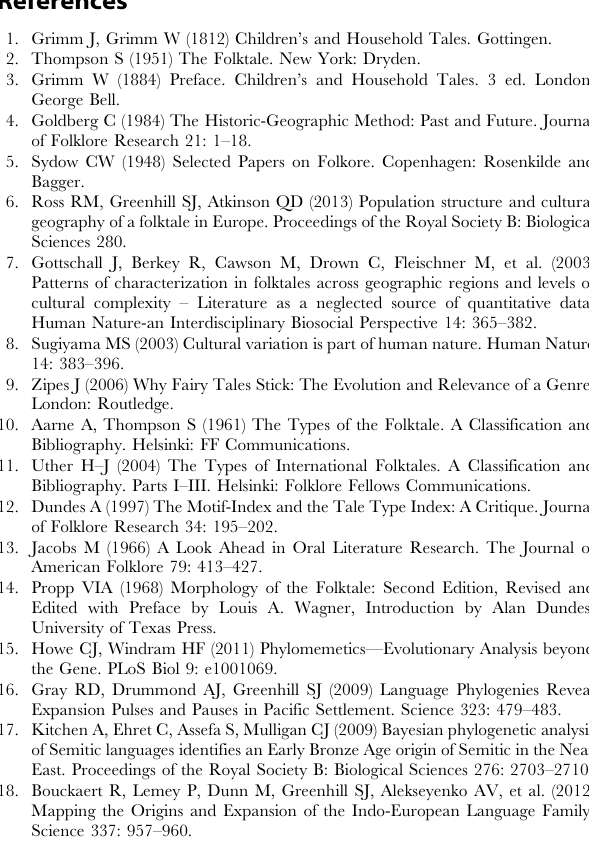
Figure S2 Maximum clade credibility tree returned by a Bayesian analysis of the data with the East Asian tales removed. Numbers represent posterior probabilities associated with each clade. Figure S3 NeighbourNet graph of the data with East Asian tales removed. The average delta score on the Network was 0.28 and the average Q-residual score was 0.024. Table S1 List of tales used in the analyses and their